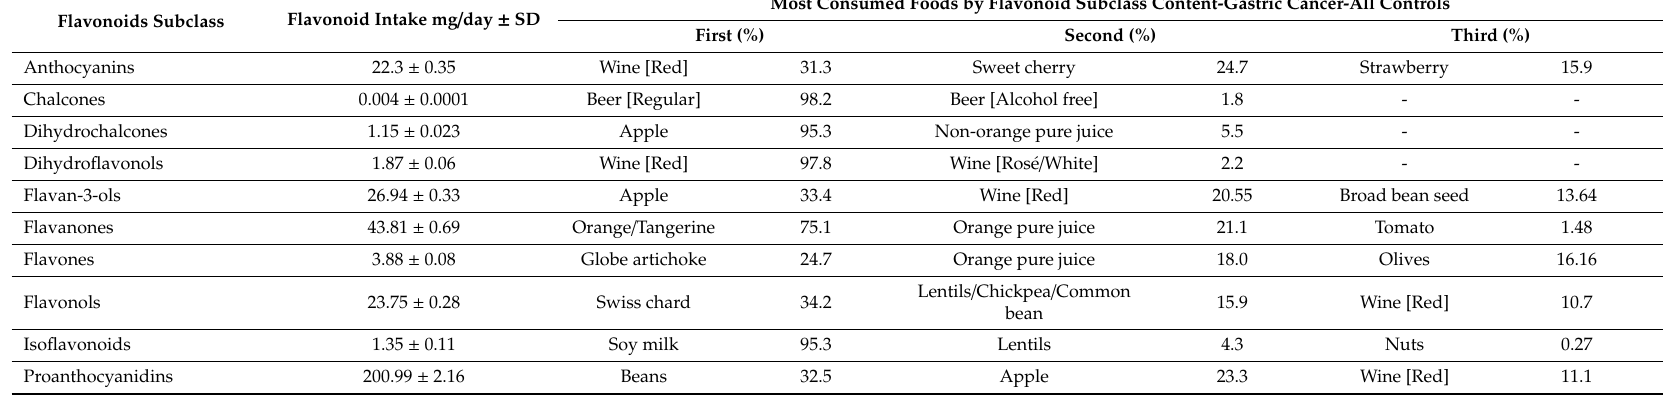
Table 2. Average flavonoid consumption (mg / day) and percentage of total flavonoid subclass daily intake in all subjects of the study sorted by the three most consumed